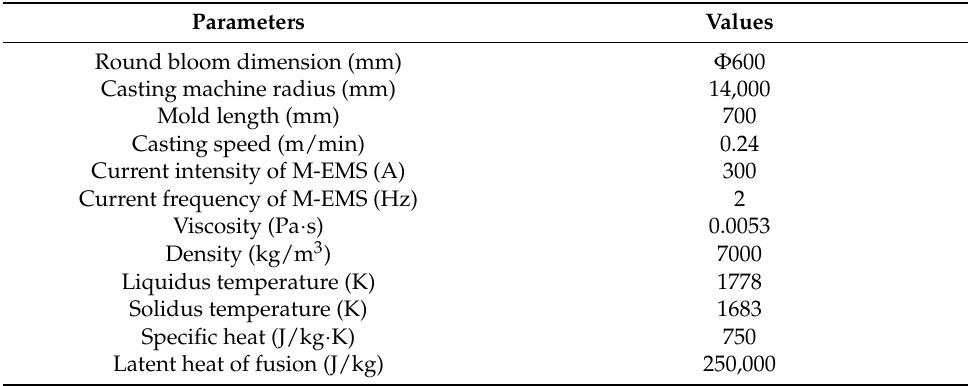
Table 3. Process conditions and physical parameters.